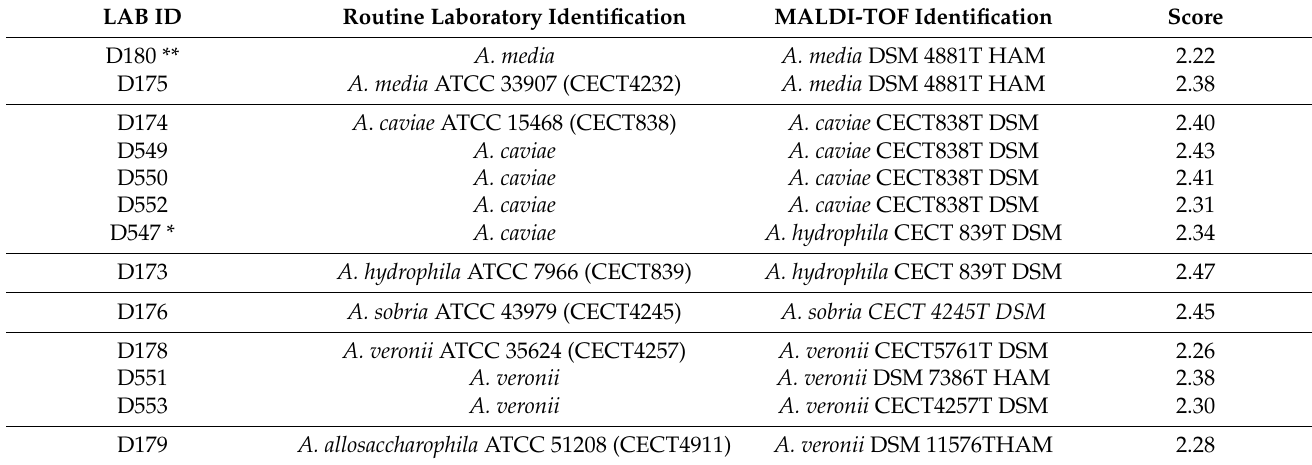
Table 1. MALDI-TOF identification of the 13 Aeromonas isolates previously identified in routine laboratory work. LAB ID Routine Laboratory